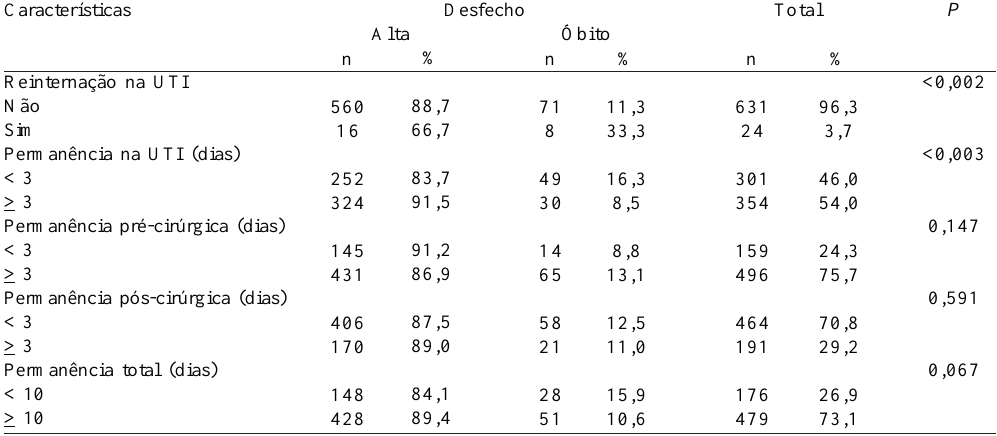
Tabela 3. Tempo de permanência hospitalar de 655 pacientes submetidos à CRM segundo os desfechos alta e